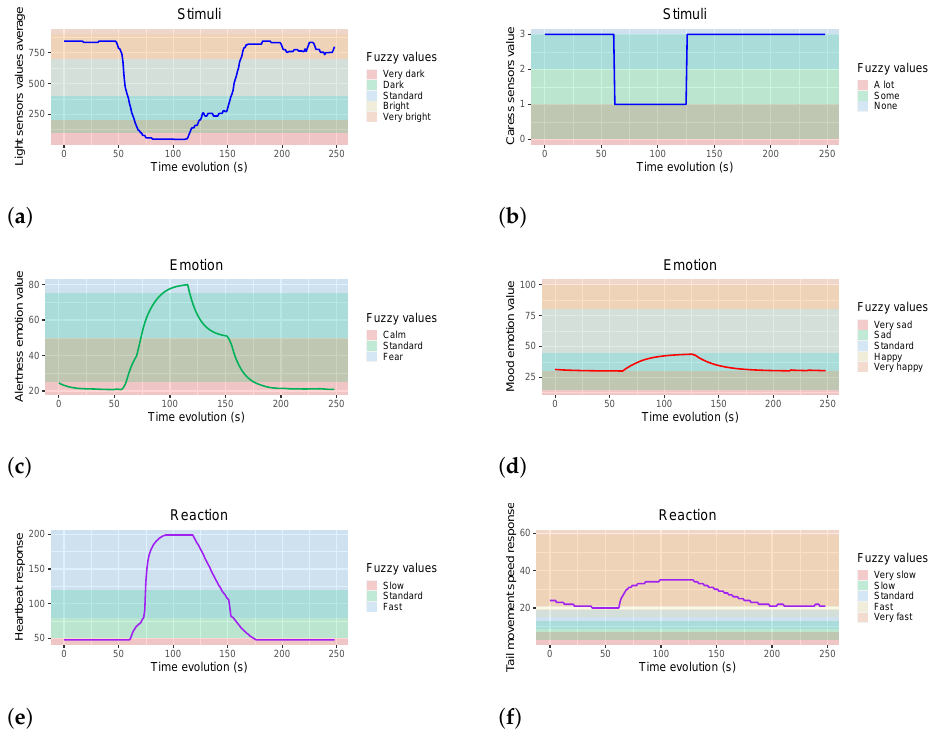
Figure 14. 2 × 3 grid of images. ( a ) Brightness stimulus. ( b ) Caress stimulus. ( c ) ALERT dimensional emotion. ( d ) MOOD dimensional emotion. ( e ) Heartbeat response. ( f ) Tail speed